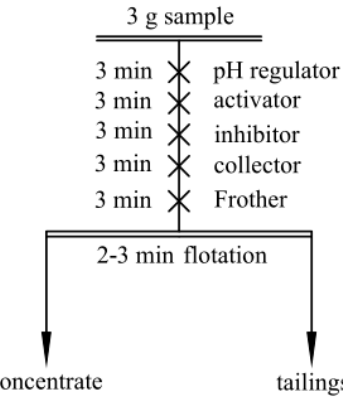
Figure 2. Flowsheet of flotation.